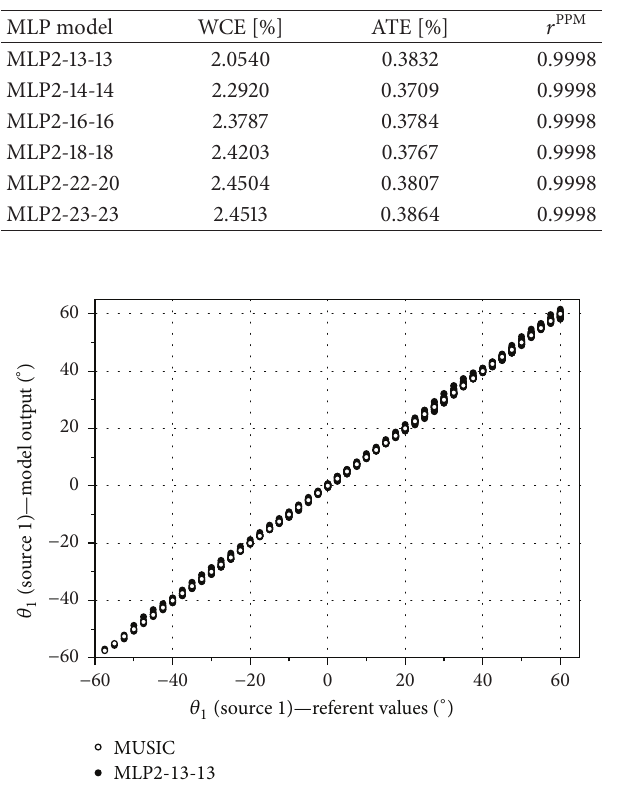
Table 4: Testing results for six MLP-DoA 2 neural network models with the best test statistics.